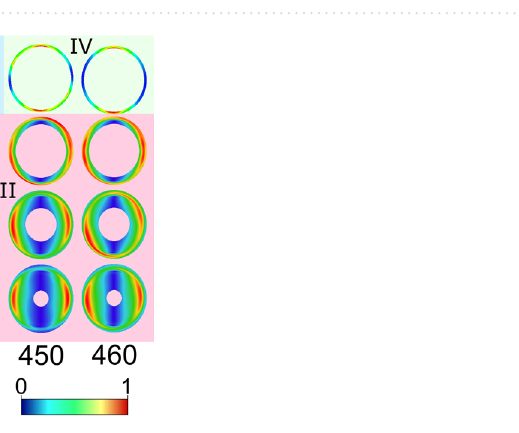
Figure 3. The imaginary susceptibility spectra of an isolated magnetic ring driven by the pulse in the x-direction for different values of the RPMA strength K and for the 4 studied values of the ring internal radius R 1 . The main mode in each curve is denoted by a green circle).